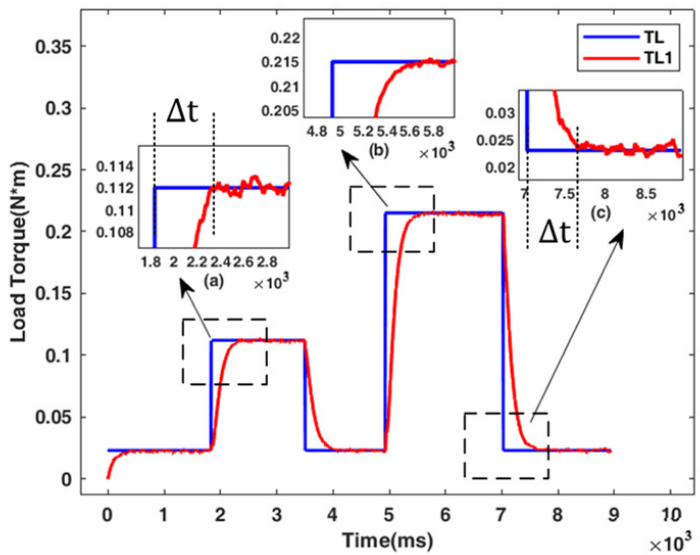
Figure 12. Actual observation results of load torque: ( a )–( c ) convergence time and torque fluctua- tion